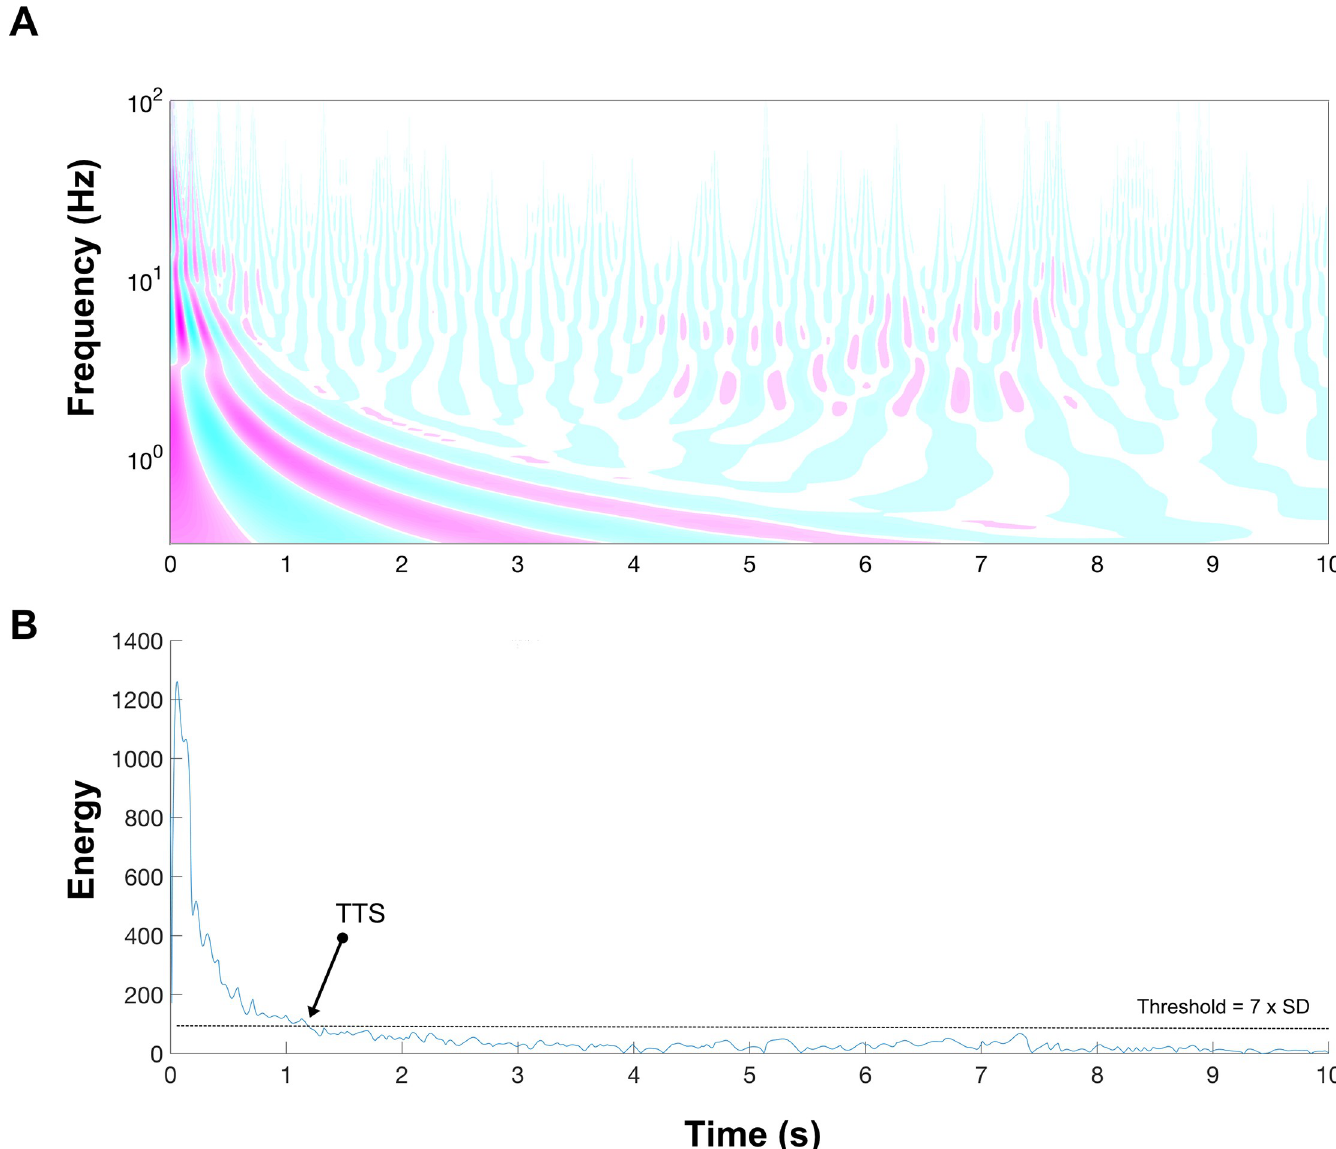
Fig 1. Example of a continuous wavelet transformation analysis performed to compute time to stabilization. A: continuous wavelet transformation surface. B: energy of the wavelet surface at each time point. TTS = time to stabilization; SD = standard deviation.